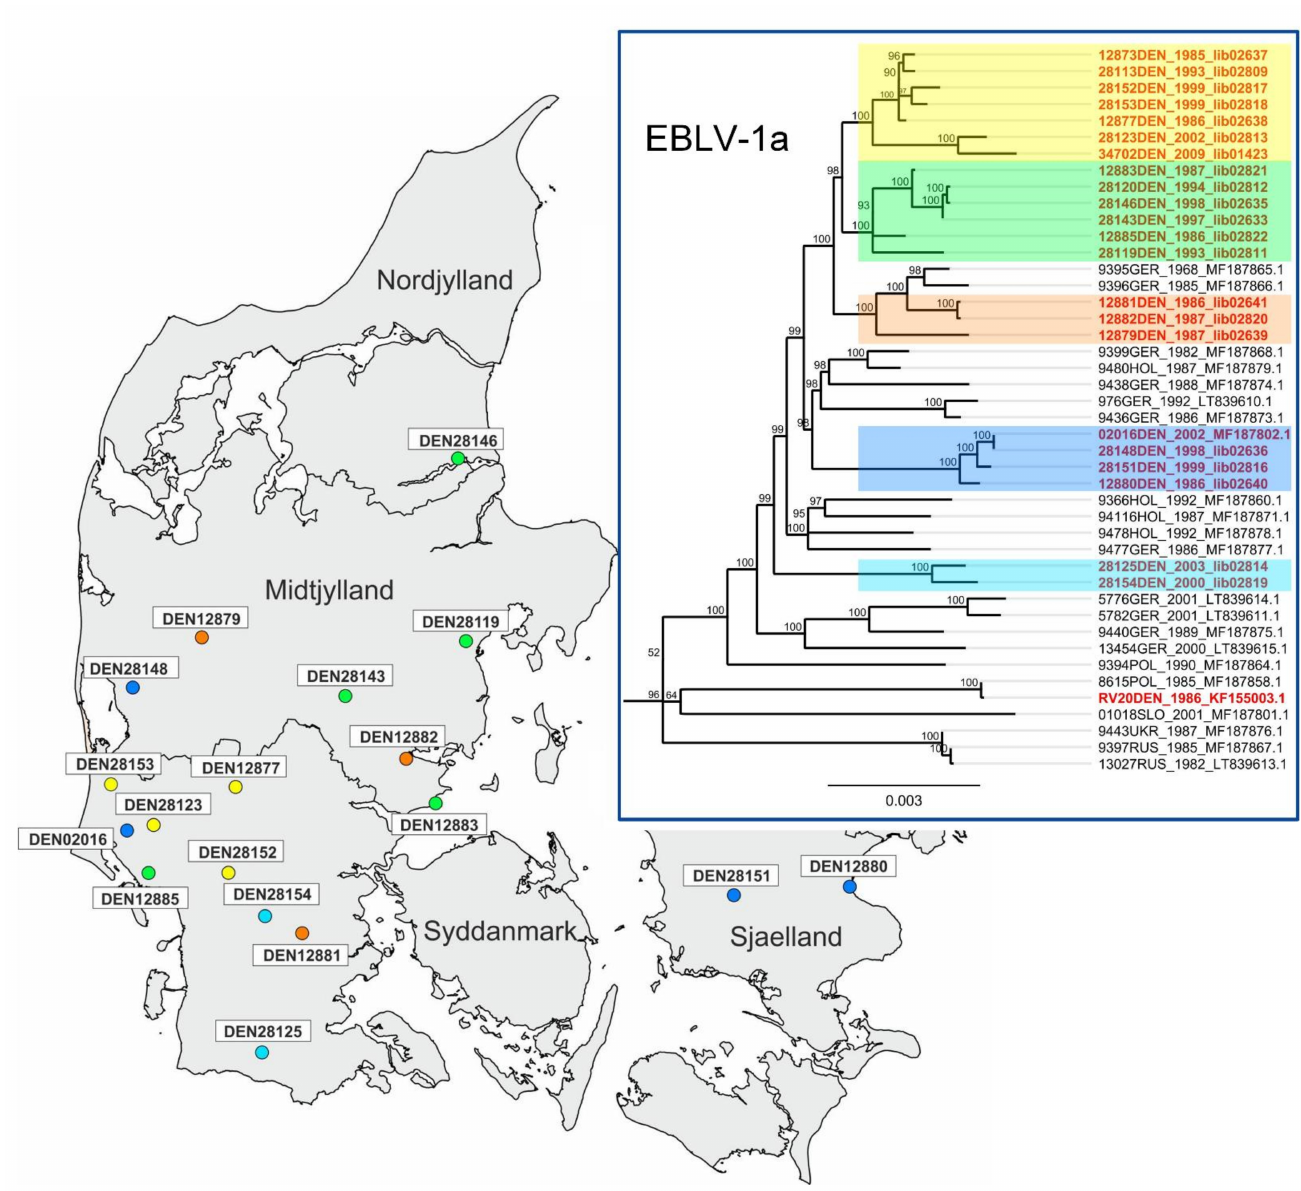
Figure 2. Map of Denmark showing the geographic location of 17 of the 21 characterized Danish EBLV-1 isolates and one of the two previously described Danish isolates available in Genbank (02016DEN). For five Danish EBLV-1 isolates no information on the geographic location was available. Insert upper right corner: Reduced maximum likelihood phylogenetic tree of sublineage EBLV-1a (N = 45) with the French EBLV-1a isolates forming a distinct cluster (Figure 1) excluded for better visualization. Ultrafast bootstrap values (percentage) are indicated at each node and branches are scaled based on the number of substitutions per site. The affiliation of the EBLV-1 isolates to one of the five putative A1 subclades of Danish origin are highlighted in different colors with yellow, green, orange, blue and cyan representing isolates from Groups 1, 2, 3, 4, and 5, respectively (Table